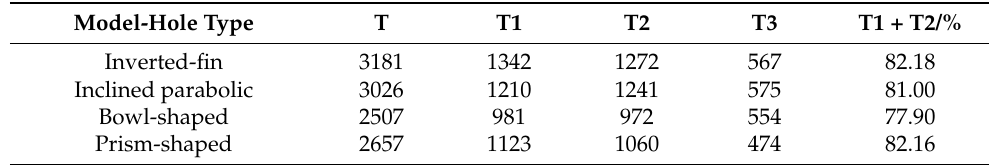
Table 5. Different filling postures of wheat.